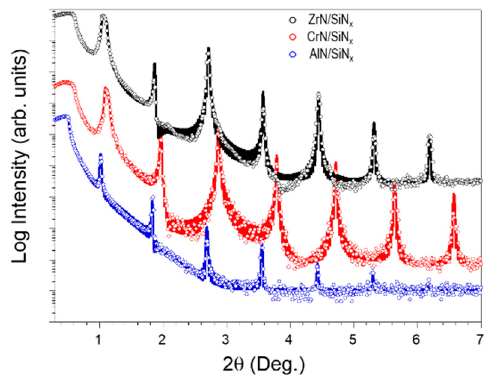
Figure 2. XRR scans of ZrN / SiN x , CrN / SiN x and AlN / SiN x multilayered films with the ratio of thicknesses of MeN and SiN x elementary layers equal to 5 nm / 5 nm. Solid lines correspond to the best-fit simulations to experimental data using optical model of Parratt.